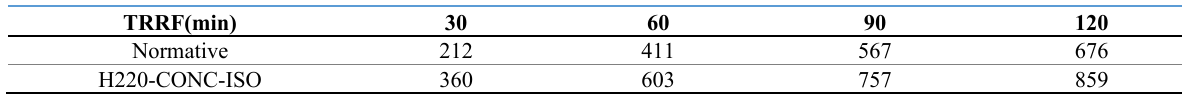
Table 9. Comparison of the temperatures obtained in the numerical model and the theoretical values for longitudinal reinforcement of the columns with heating on all